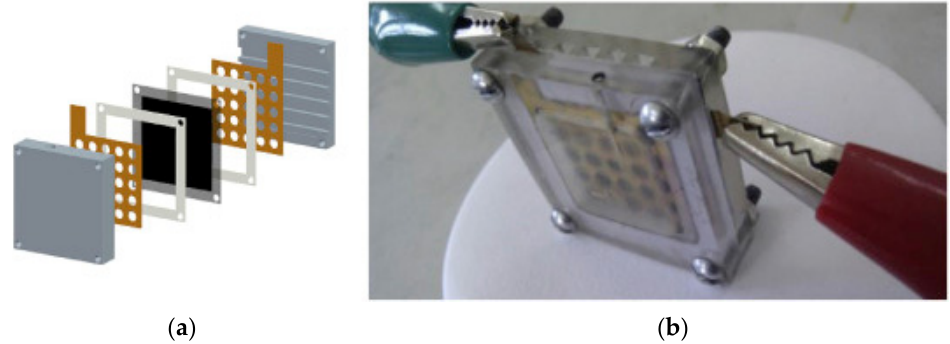
Figure 6. Assembled PS-DMFC: ( a ) schematic of the structure; ( b ) picture of the device. Reproduced from [110] with permission from Elsevier 2018. from [110] with permission from Elsevier